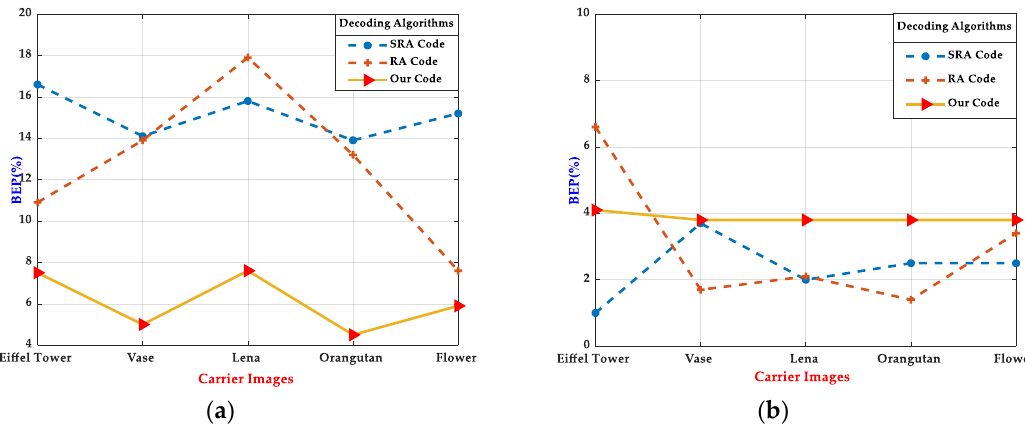
Figure 10. Decoding robustness comparisons in terms of demodulation bit error probability (BEP) in printed photos taken in actual scenes ( a ) and digital pictures ( b ).